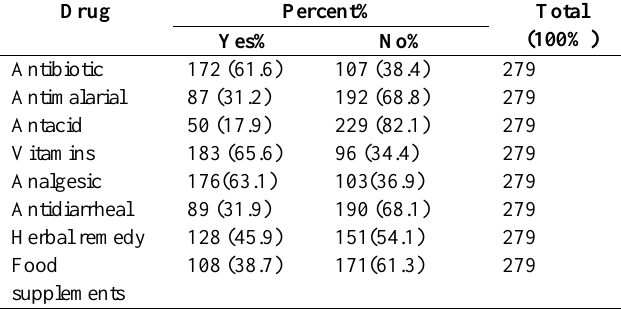
Table 5: Distribution of the population according to the source of